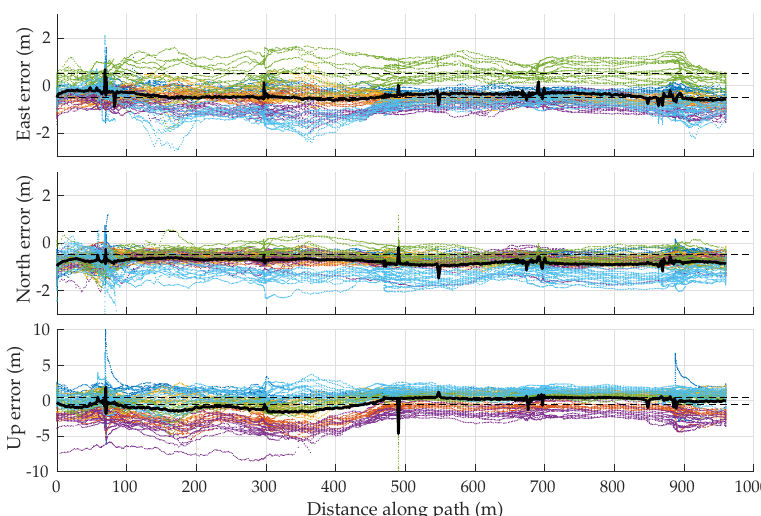
Figure 13. Errors in enhanced code-phase position estimates with respect to ground truth in the east, north, and up directions. Different colors distinguish data from six different campaigns. The dashed reference lines are drawn at ± 50 cm. The solid black lines show the mean positioning error over the six campaigns. The error standard deviation is nearly constant along the path in the horizontal plane at ∼ 0.6 m in the east and ≈ 0.4 m in the north direction. In the up direction, the standard deviation is ∼ 2.1 m for the first 400 m along the path, and ≈ 1.3 m for the rest.